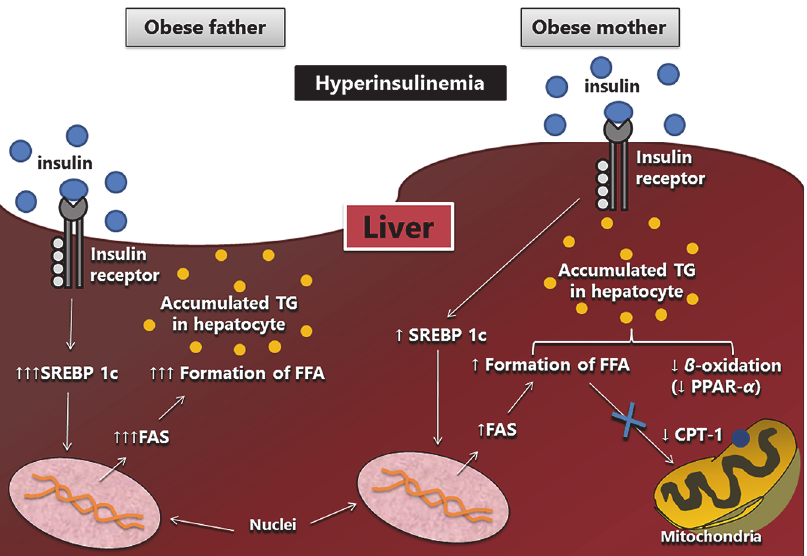
Fig 8. Scheme of the mechanisms obtained in the study. Liver steatosis observed in offspring of obese father and obese mother is possibly the result of different activated pathways, resulting from a framework of hyperinsulinemia. It is suggested that the paternal obesity intensifies the lipogenesis pathway through increased gene and protein expression of SREBP-1c, which stimulates the synthesis of fatty acids by the FAS enzyme. Maternal obesity led to a less intense lipogenesis and decreased beta-oxidation showed by a lower gene and protein expression of PPAR alpha and CPT-1. Arrow-up ( " ) indicates an increase and arrow- down ( # ) indicates a decrease in both gene and protein expressions. Abbreviations: sterol regulating element binding protein (SREBP-1c); fatty acid synthase (FAS); peroxisome proliferator activator receptor alpha (PPAR-alpha); carnitine palmitoyltransferase I (CPT-1); free fatty acid (FFA).